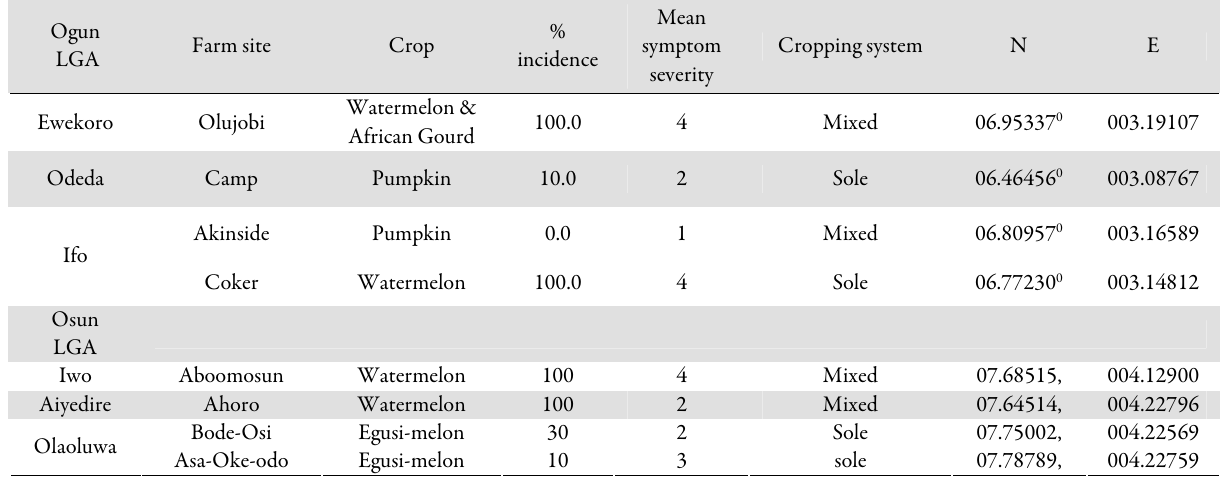
Tab. 2. Distribution of virus-like symptoms on cucurbit crops grown in Ogun state in June 2012